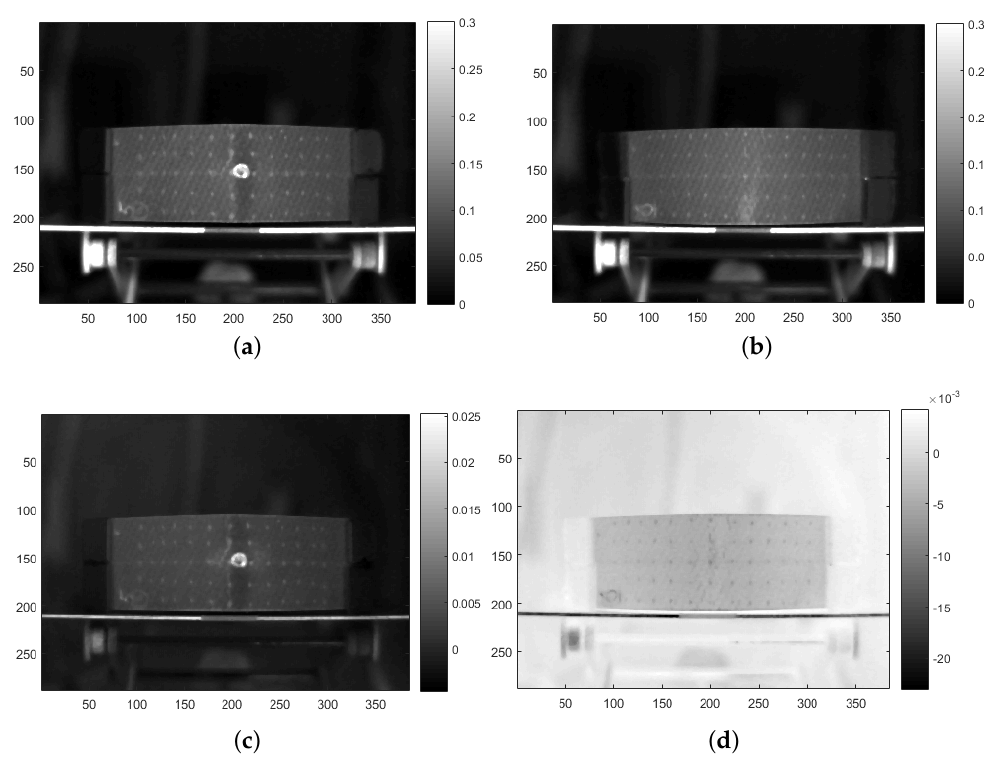
Figure 5. PCT second components obtained from: MWIR sequences, ( a ) specimen 5 (impacted) and ( b ) specimen 6 (non-impacted); and LWIR sequences, ( c ) specimen 5 (impacted) and ( d ) specimen 6